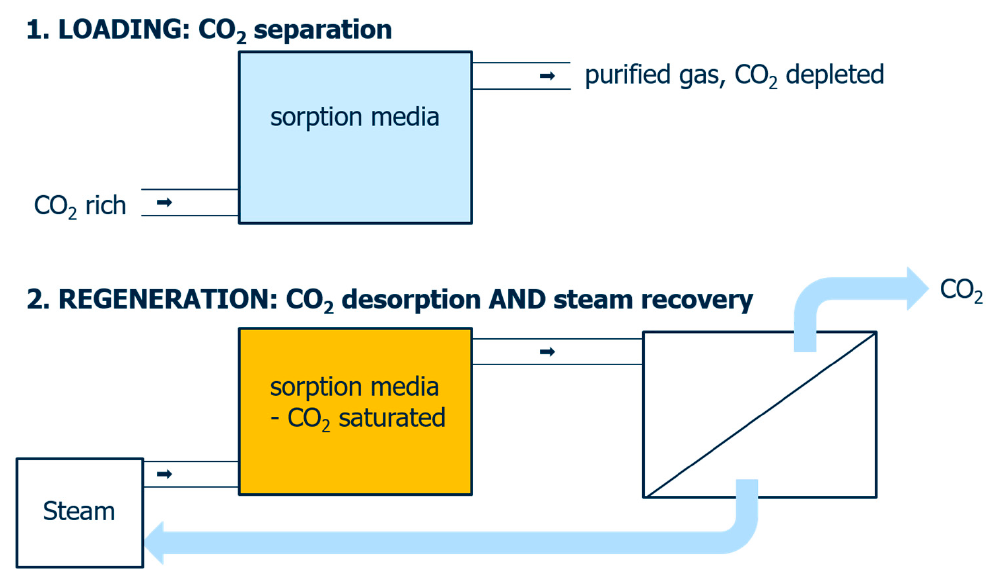
Figure 9. Two-step CO 2 enrichment process including (1) loading of a sorbent with CO 2 and (2) regeneration via steam with membrane separation downstream and an integrated water/heat recycle.